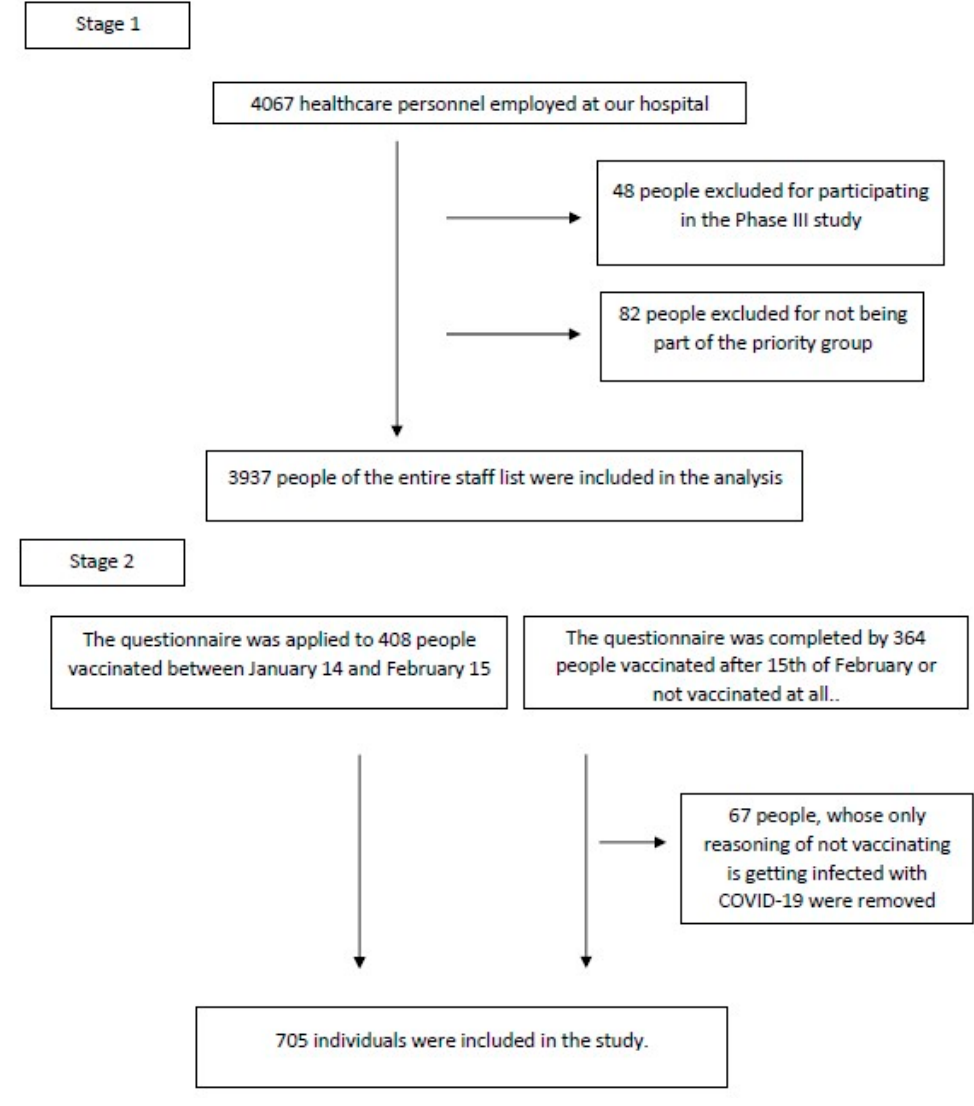
Figure 1. Selection of